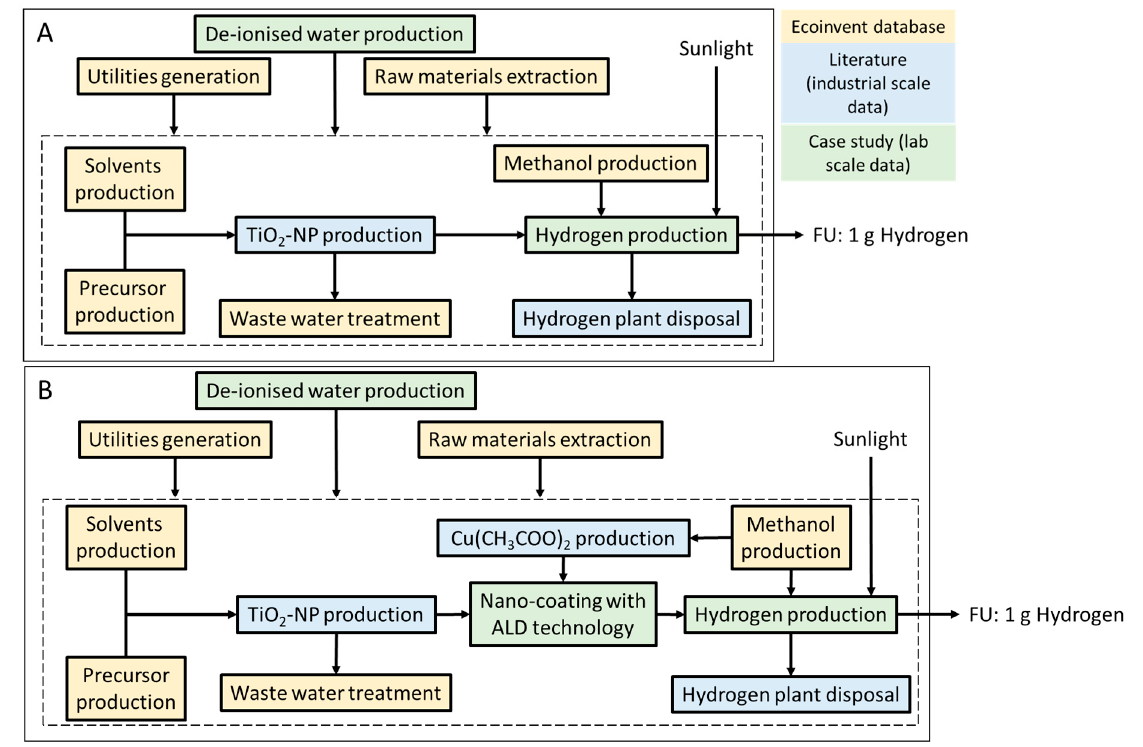
Figure 3. System boundaries of systems ( A ) P25 ‐ TiO 2 and ( B ) Cu 2 O/P25 ‐ TiO 2 .